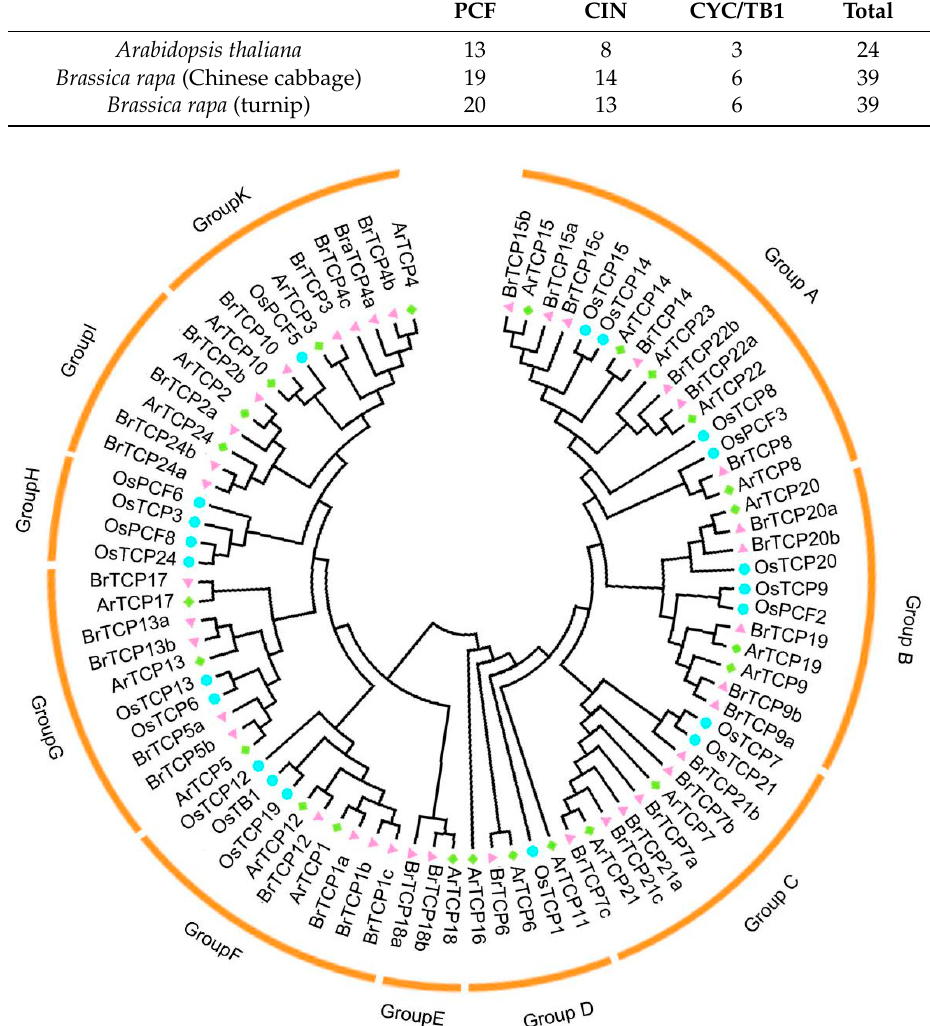
Figure 2. Phylogenetic relationships of TCP transcription factors among Brassica rapa , Arabidopsis thaliana and Oryza. sativa . The unroot phylogenetic tree was constructed by MEGA 6.0 (Tokyo Metropolitan University, Tokyo, Japan) using Neighbor-Joining method with 1000 bootstrap replicates. TCPs of different plants are indicated with different colors and shapes.